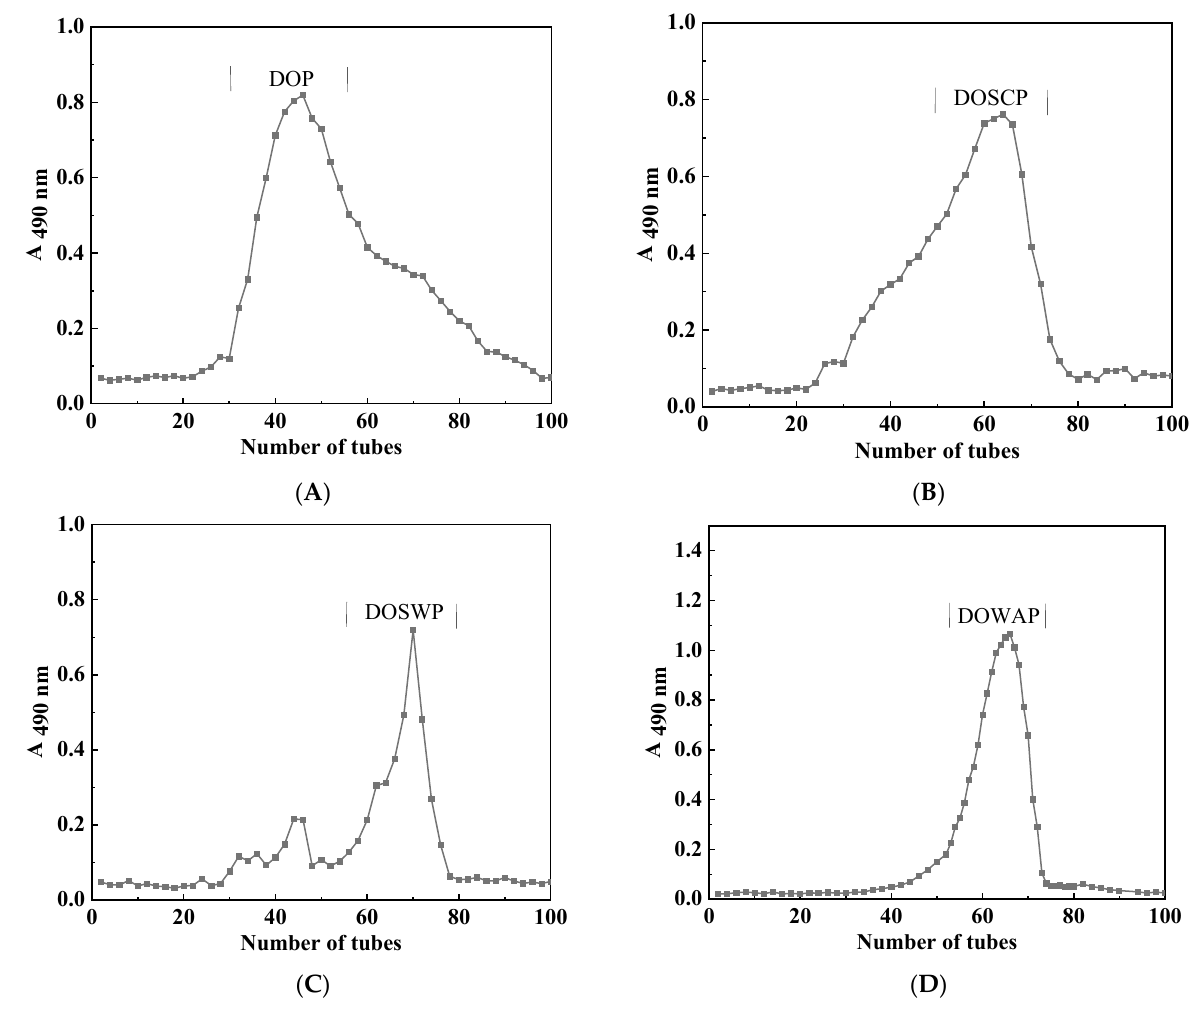
Figure 1. Elution curves of polysaccharides. ( A ) DOSCP, ( B ) DOWAP, ( C ) DOSWP, and ( D ) DOP. Table 3. Mw, monosaccharide composition and chemical composition.